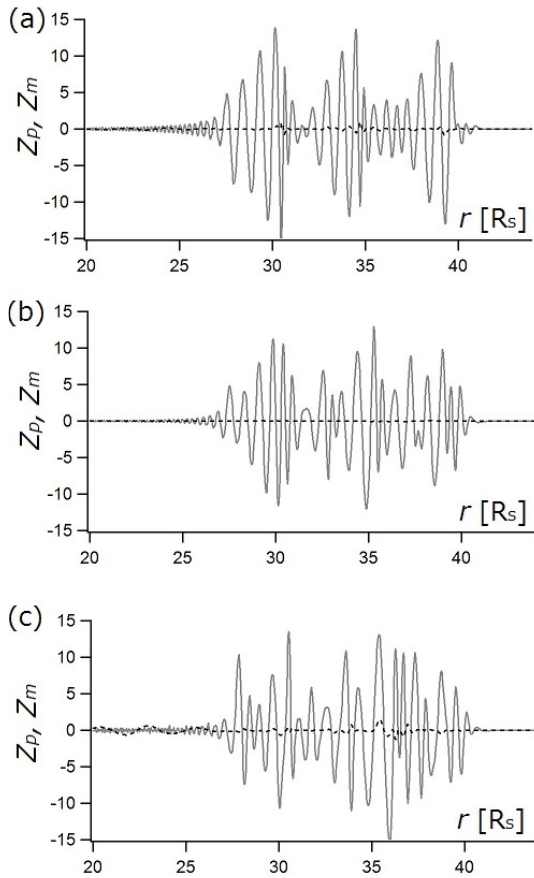
√ ρ (gray solid line)